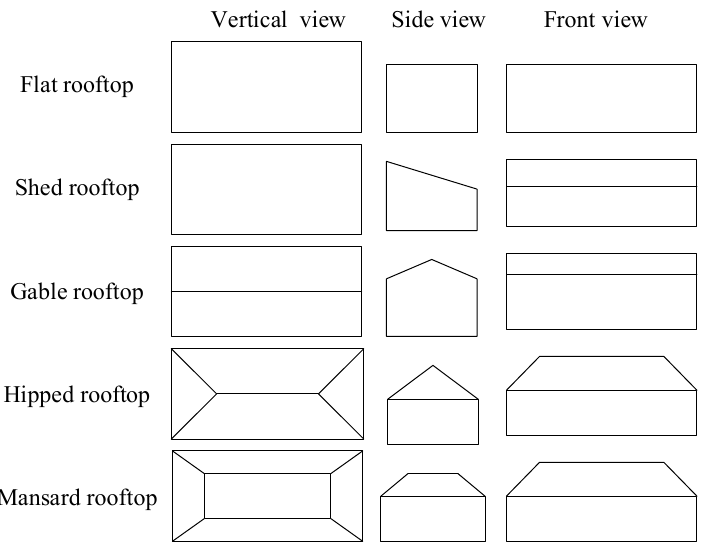
Figure 8. Sketch of different kinds of rooftops.